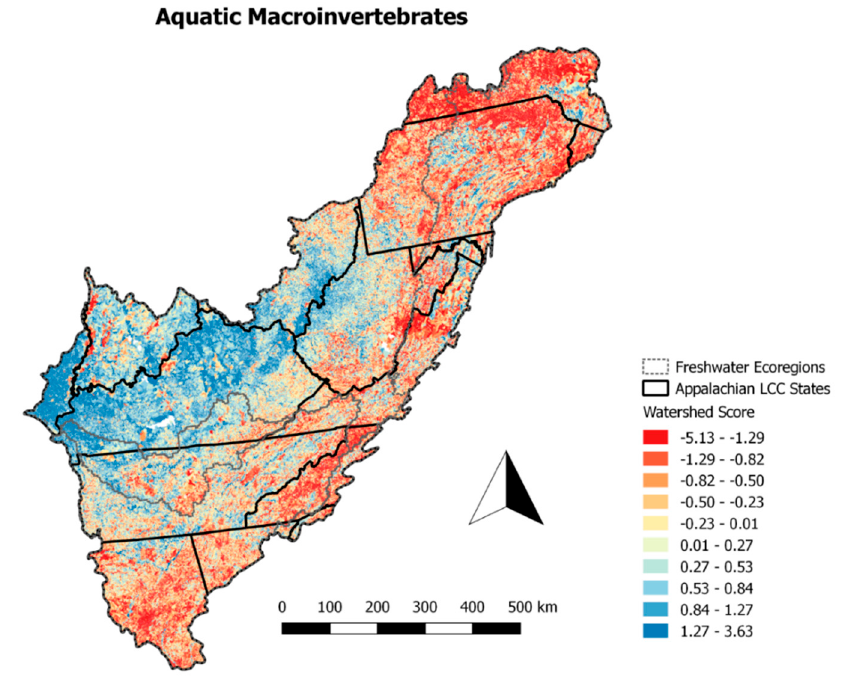
Figure 5. Global watershed scores from the boosted regression tree models for aquatic macroinvertebrates. Watershed scores were centered and scaled. Map created by R. Daniel Hanks using ArcGIS v10.3